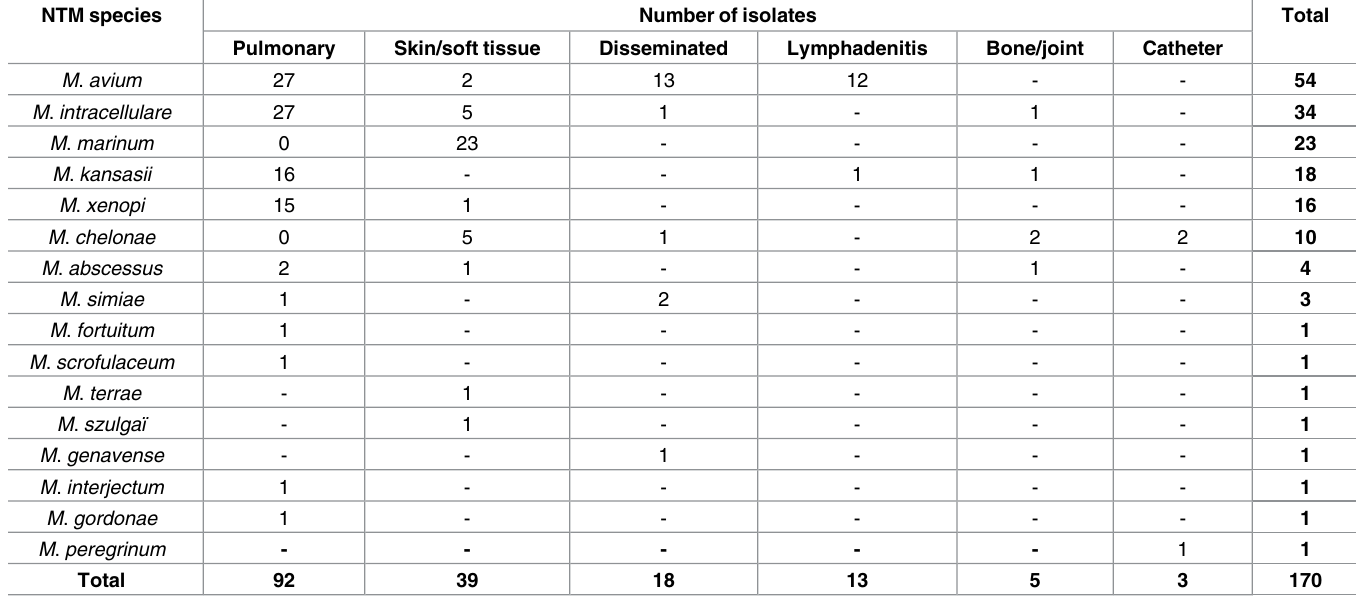
Table 2. Species and site of infection of NTM isolated at the Bordeaux University Hospital, France, between 2002 and 2013 (n = 170). NTM